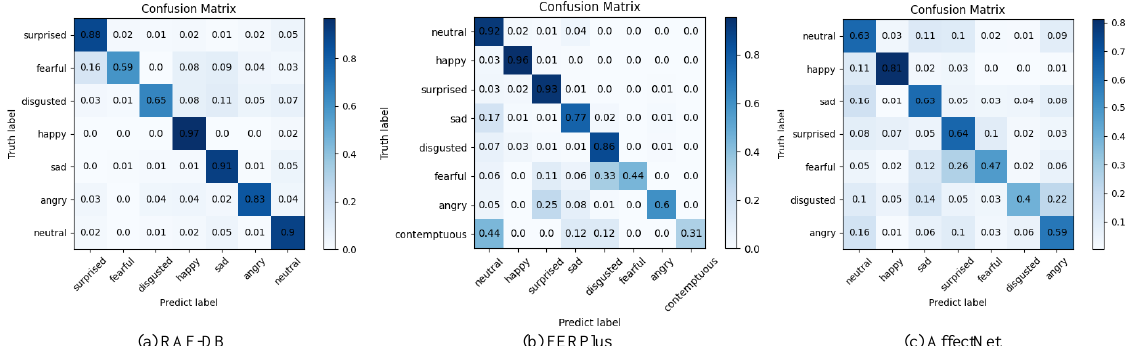
Figure 7. Confusion matrix of the RAF-DB, FERPlus, and AffectNet datasets. The horizontal axis represents the predicted label, and the vertical axis represents the true label. The diagonal line shows the accuracy of each type of prediction. Darker colors indicate higher accuracy.